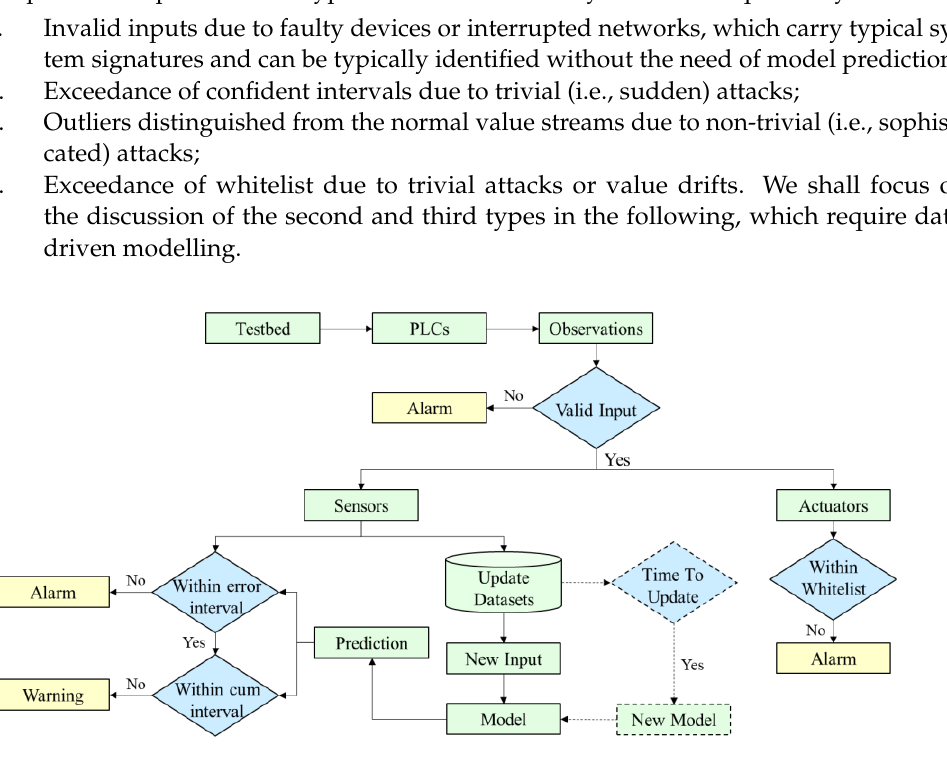
Figure 3. Conceptual overview of CADF. Note that model updating (dashed part) is currently not included in this study.